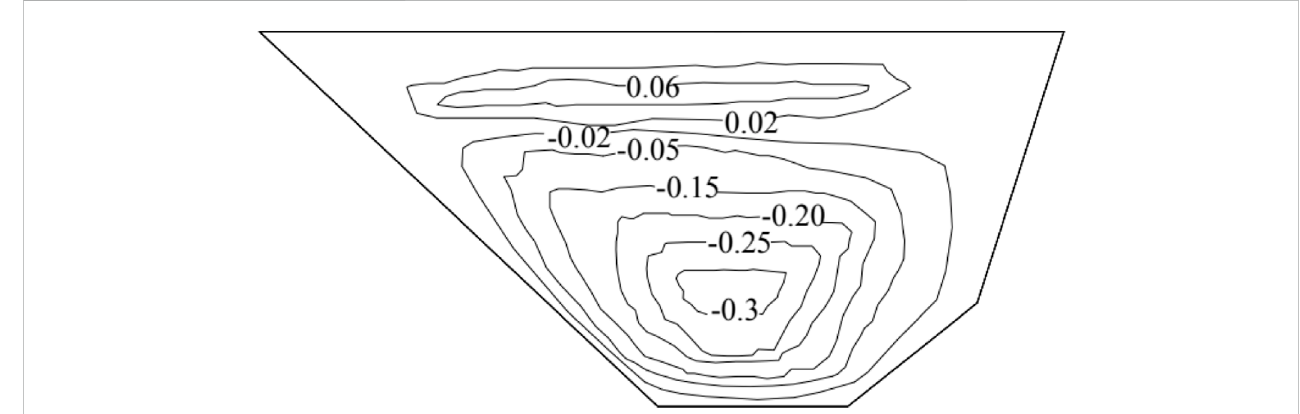
FIGURE 13 Horizontal deformation of the extruding side-wall in Completion period (unit: m).